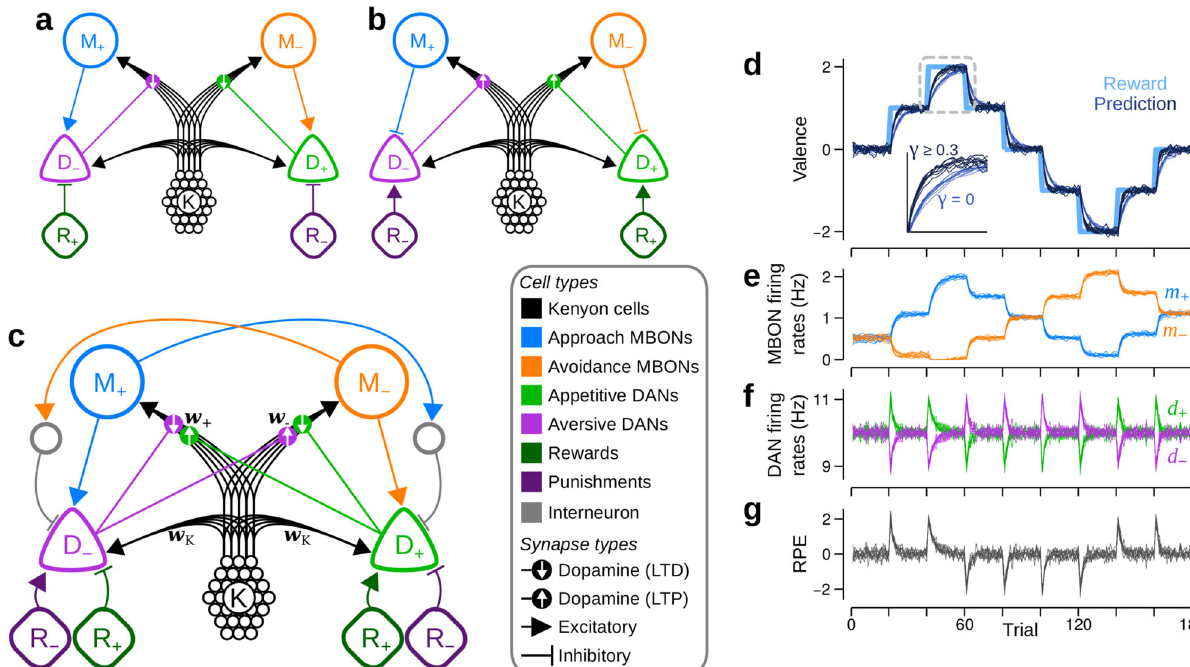
Fig. 3 Dual versions of unbounded valence-speci fi c (VSu) models can be combined to create the mixed-valence (MV) model, which also learns unbounded RPs. a – c Schematics of different circuit models. Colours and line styles as in Fig. 1c. a One of the dual, VSu models that requires D − and D + to be inhibited by positive and negative reinforcements, respectively. Lines with fl at ends correspond to inhibitory synapses. b The second of the dual VSu models, in which MBONs (mushroom body output neurons) provide inhibitory feedback to DANs of the same valence. Upward arrows in the dopamine synapses denote that dopamine induces long term potentiation (LTP). c The MV model, which combines the dual VSu models. Grey units are inhibitory interneurons. d – g Each panel exhibits the behaviour from 10 independent runs of the model. d RPs are unbounded and accurately track the reinforcements, but the learning speed depends on γ , the KC (Kenyon cell) → DAN (dopamine neuron) synaptic weights. Thick, light blue: reinforcement schedule; thin, dark blue: γ = 0; thin, very dark blue: γ ≥ 0.3. Inset: magni fi ed view of the region highlighted by the dashed square, showing how learning is slower when γ = 0. e M + (blue) and M − fi ring rates, respectively m + and m − , when γ = 1. f D + and D − fi ring rates, respectively d + and d − , when γ = 1. g RPEs (reinforcement prediction errors) as given by the difference between D + and D − fi ring rates when γ =